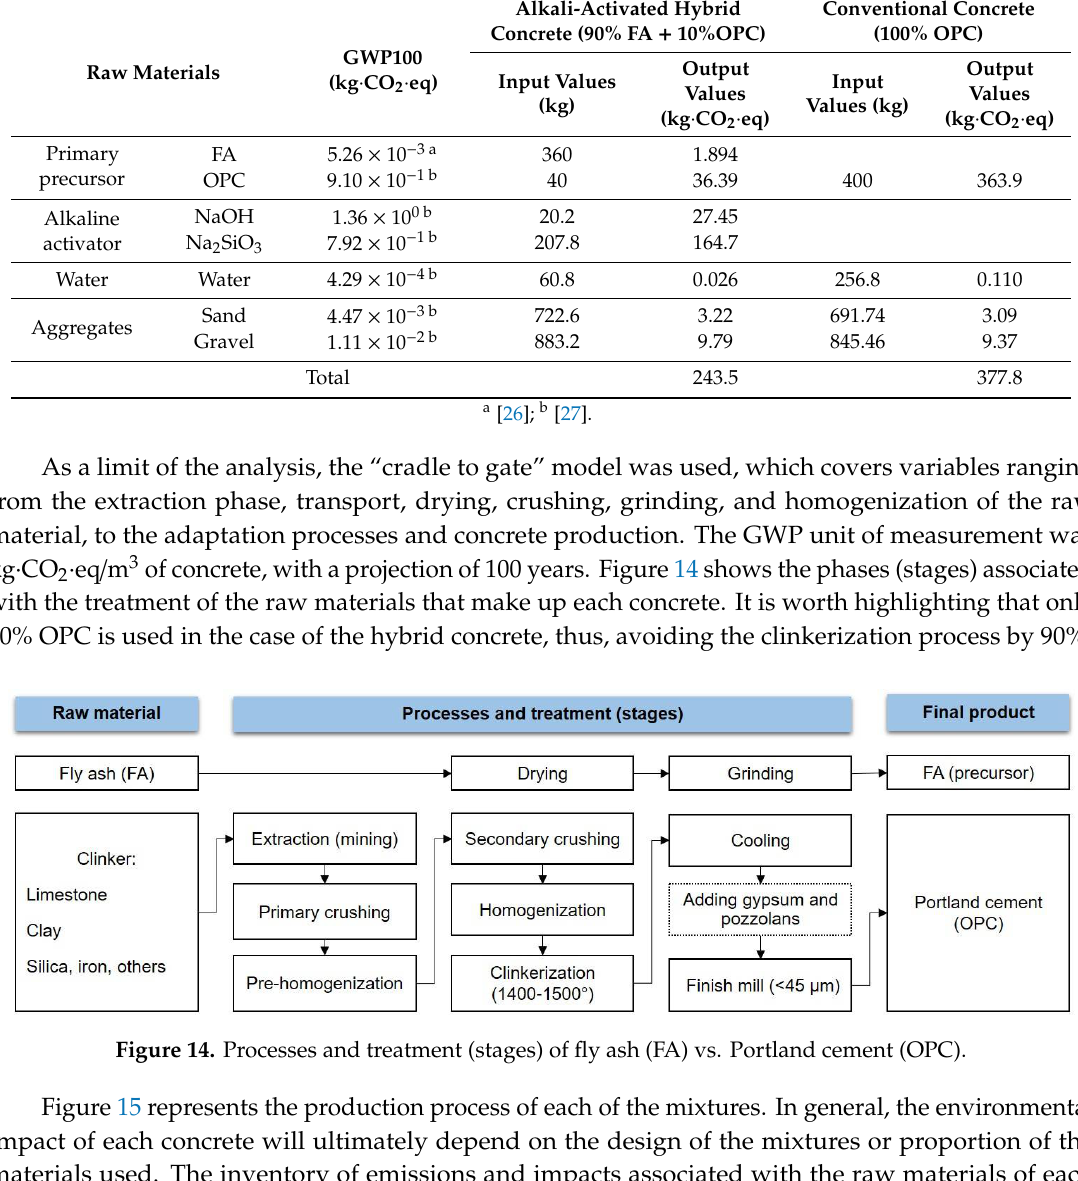
Figure 15. Production process of alkali-activated hybrid concrete (90% FA–10% OPC) vs. 100% OPC- based conventional concrete. Table 8. Inventory of emissions and impacts associated with raw materials of alkali-activated hybrid concrete (90% FA–10% OPC) compared to a conventional concrete based 100% on OPC. Raw Materials